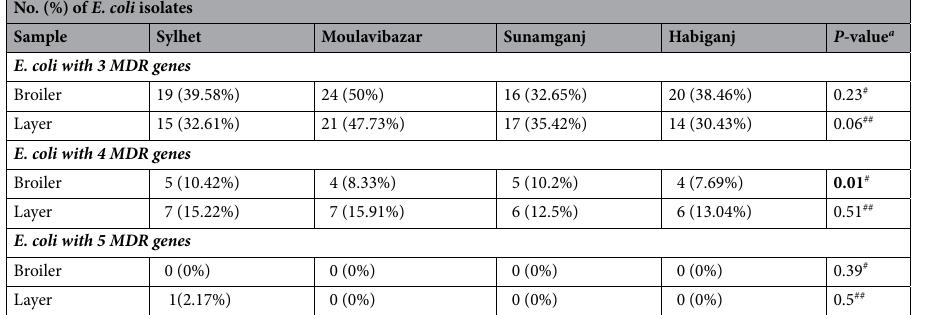
Table 7. Prevalence and distribution of MDR genes among the investigated E. coli ( n = 381) isolates in relation to the four districts of Sylhet division under study. a P values were calculated using a two-way analysis of variance (ANOVA) without replication. P values < 0.05 are highlighted in bold. # Variance between broiler and layer chickens. ## Variance among the four districts under